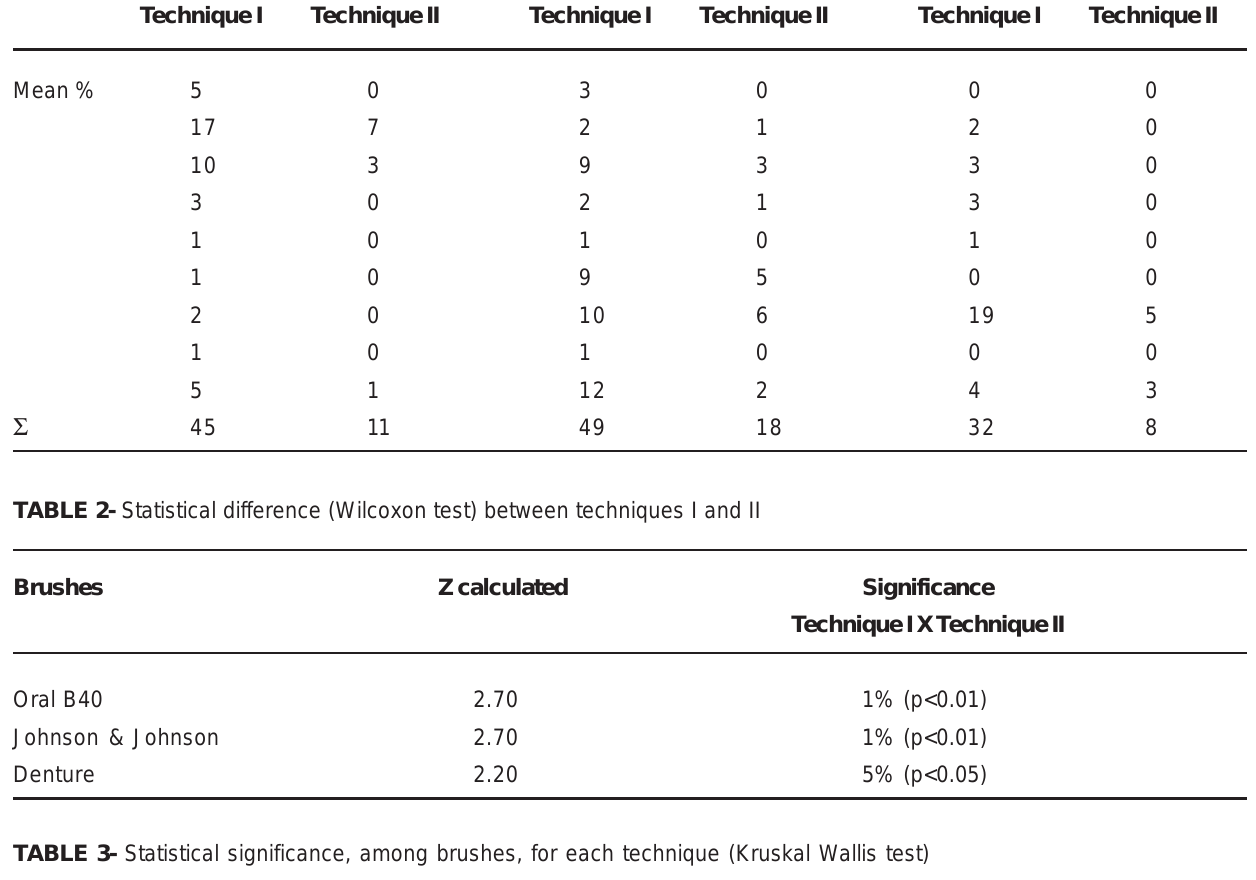
TABLE 3- Statistical significance, among brushes, for each technique (Kruskal Wallis test) Brushes